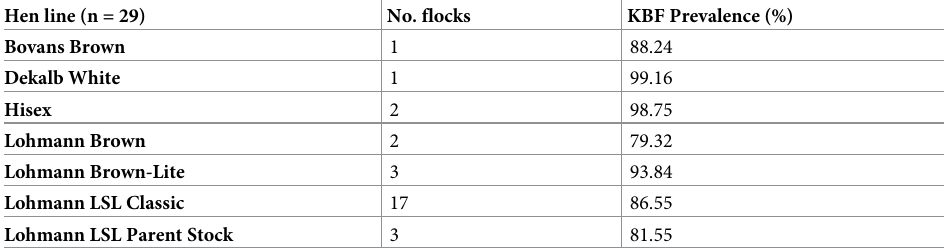
Table 2. Distribution of the hen lines in 29 flocks out of the study population.